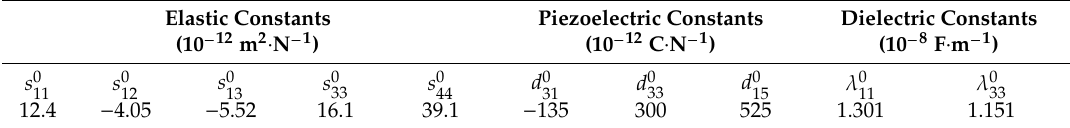
Table 1. Physical properties of material PbZrTiO 3 -4 (Generally abbreviated as PZT-4).